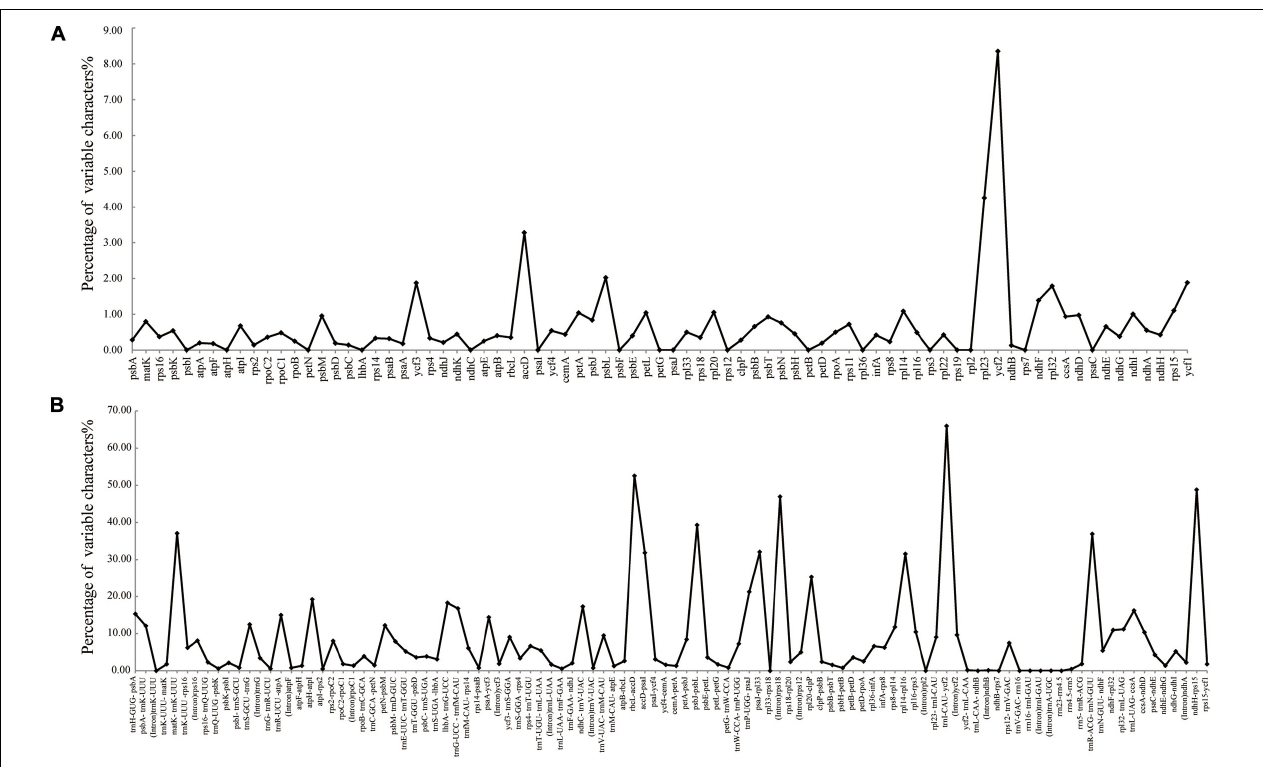
FIGURE 5 | Percentages of variable sites in homologous regions across the 14 Dipelta plastomes. (A) Protein-coding sequences (CDS). (B) The introns and spacers